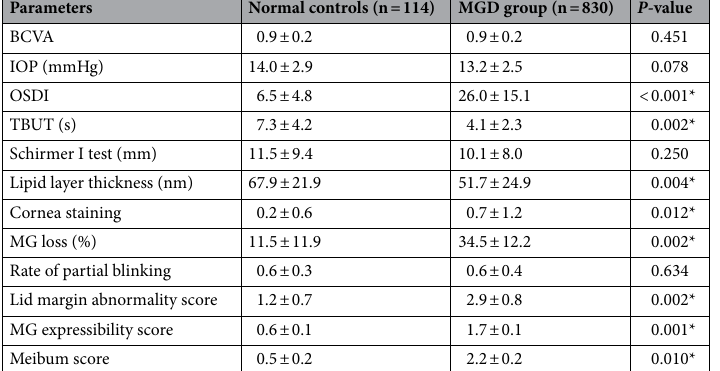
Table 3. Ocular surface evaluation in normal controls and MGD group. BCVA best-corrected visual acuity, IOP intraocular pressure, MGD meibomian gland dysfunction, TBUT tear film break-up time. *P < 0.05 was considered statistically significant.